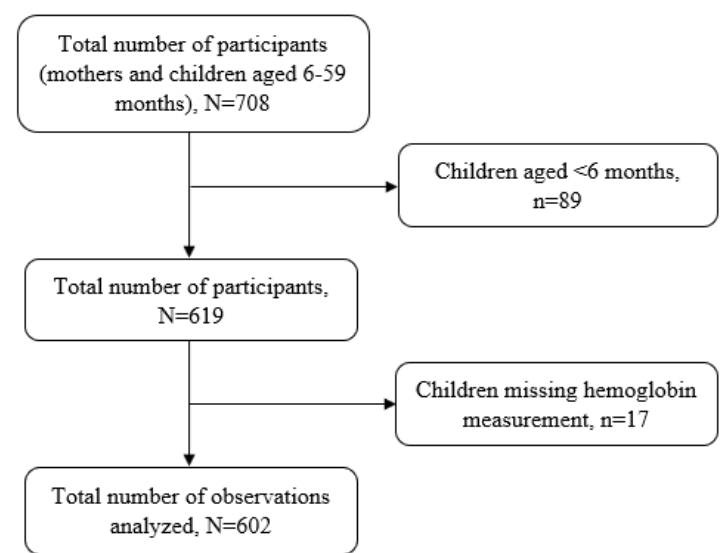
Figure 1. Schematic diagram showing the number of